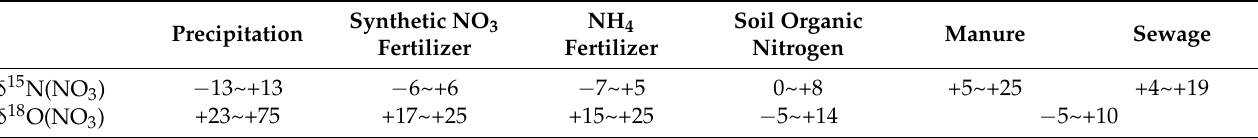
Table 2. Ranges of δ 15 N(NO 3 ) and δ 18 O(NO 3 ) originating from different sources (unit: